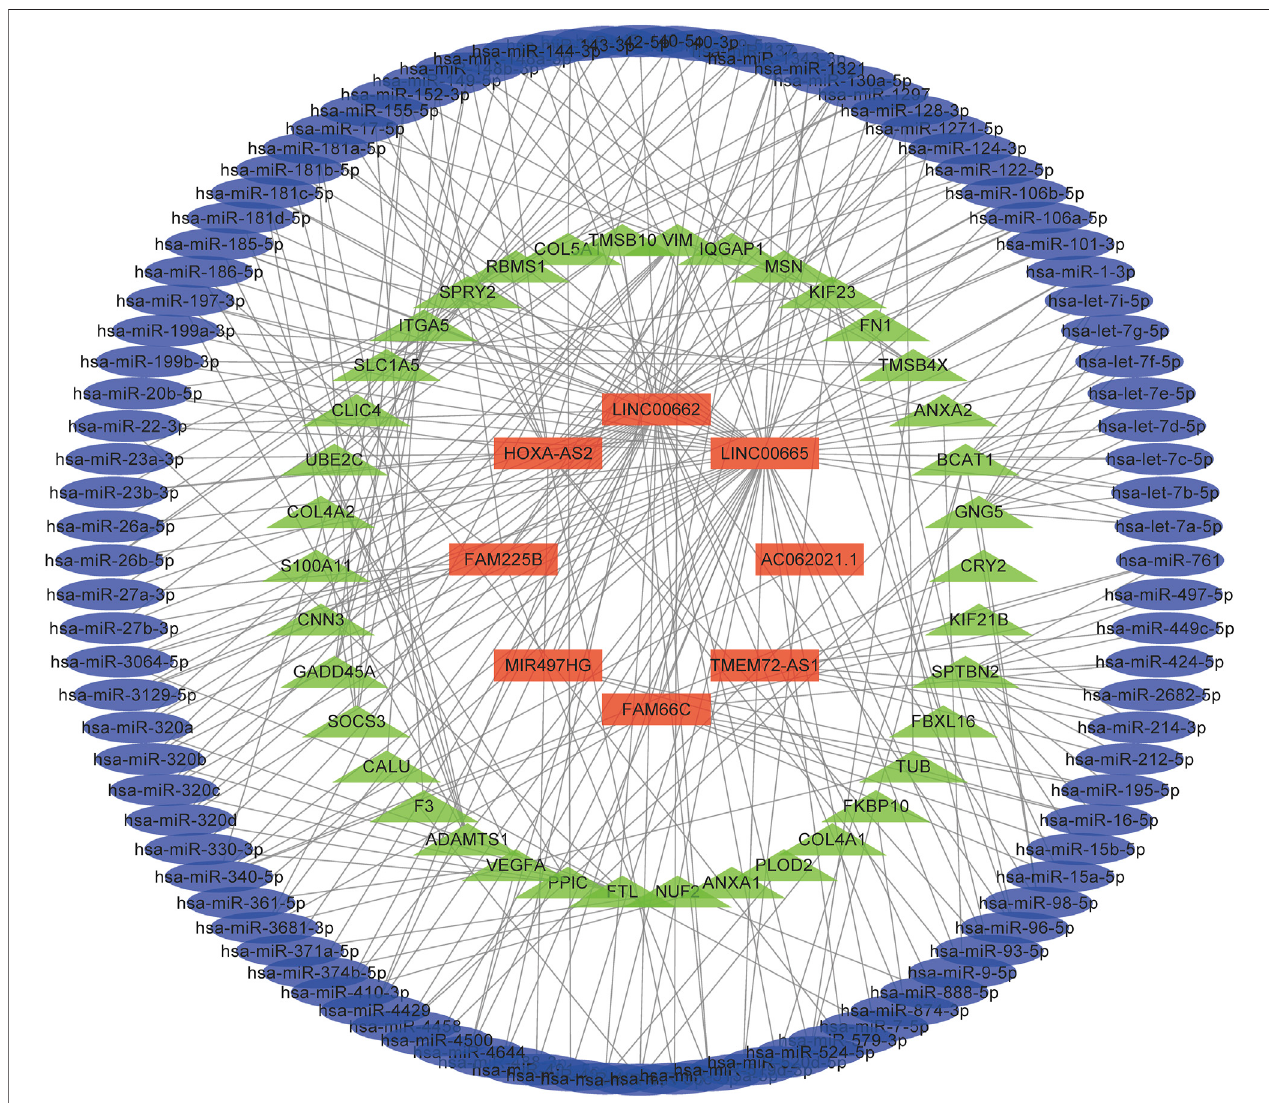
FIGURE 7 | A ceRNA network in the regulation of glioma. Light blue, light green, and red colours represent miRNAs, mRNAs, and lncRNAs, respectively.